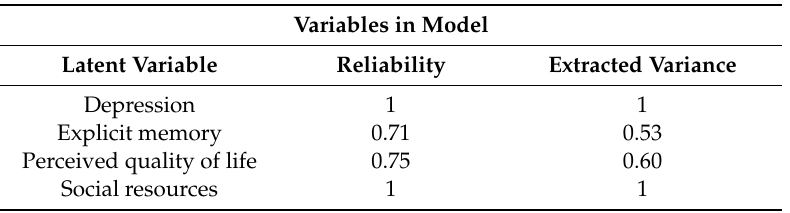
Table 1. Extracted variance and